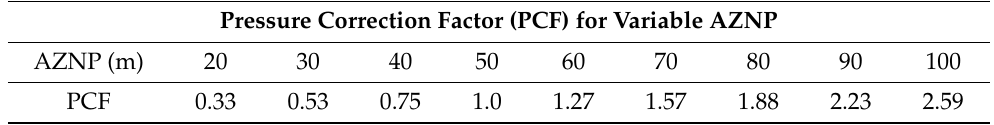
Table 1. Pressure correction coefficient used for leakage calculation [22,24].